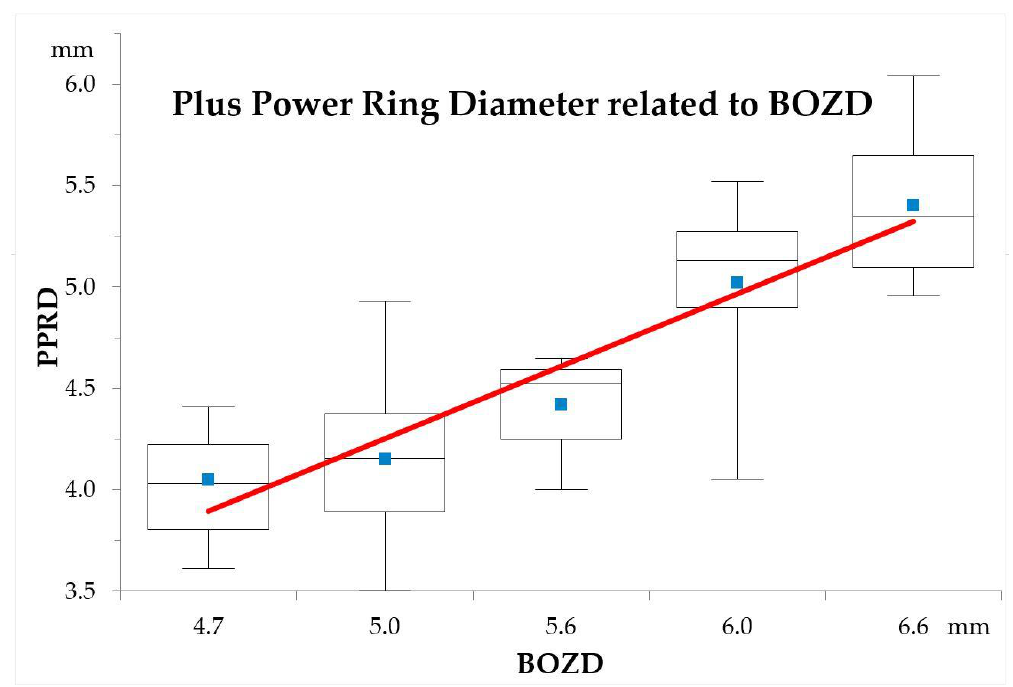
large back optic zone diameter, S_BOZD: small back optic zone diameter.